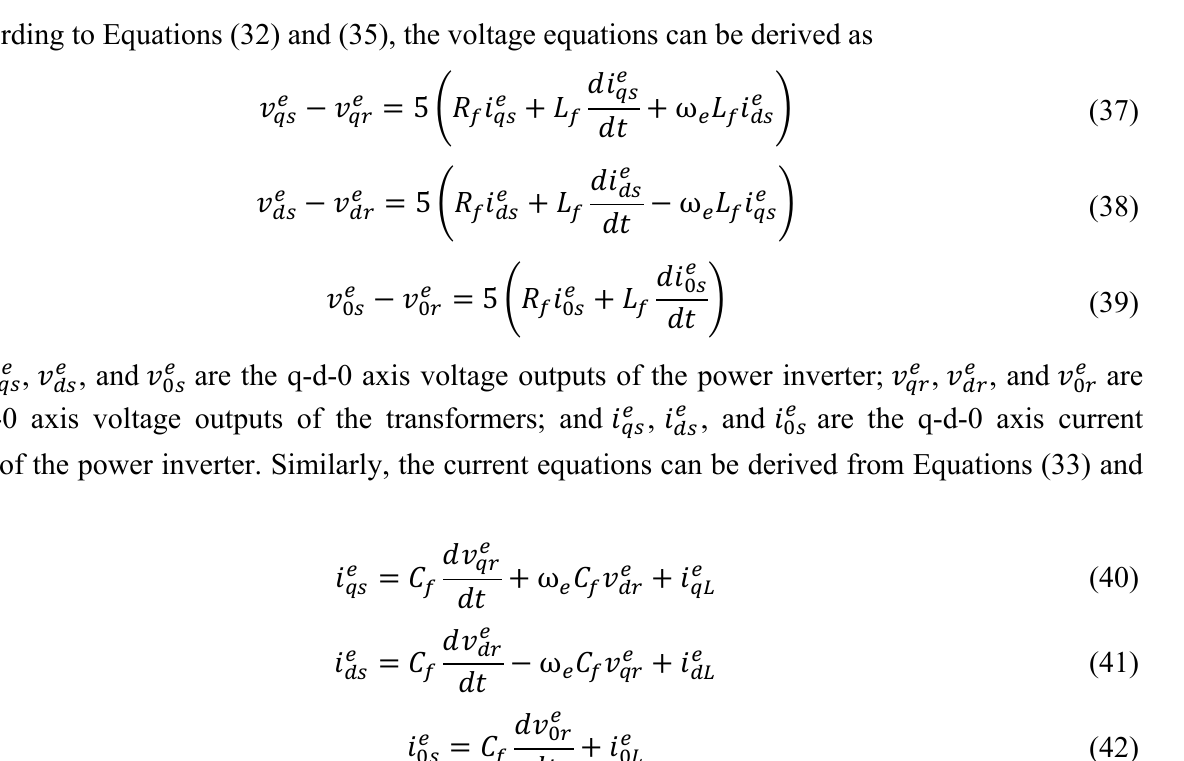
Figure 11. Equivalent circuit of the low-pass